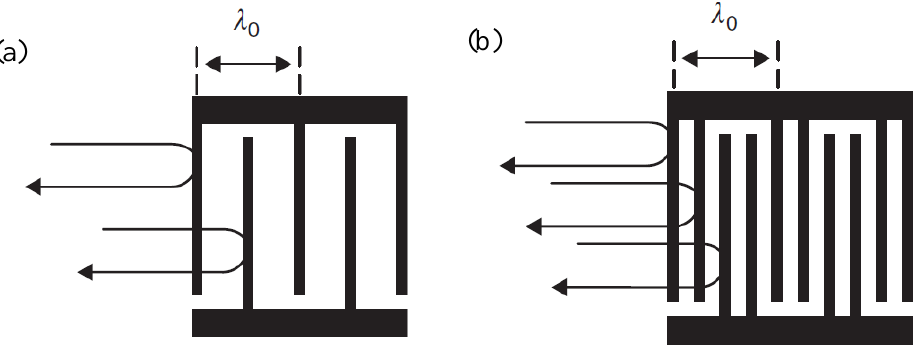
Figure 6. The reflection of SAW ( a ) single-electrode IDT; ( b ) split-finger electrode IDT, adapted with permission from [4].